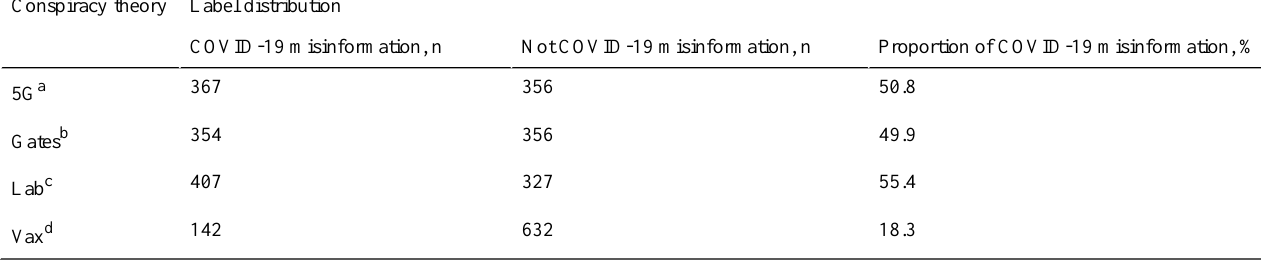
Table 3. Distributions of labels for the four COVID-19 conspiracy theories. Label distributionConspiracy